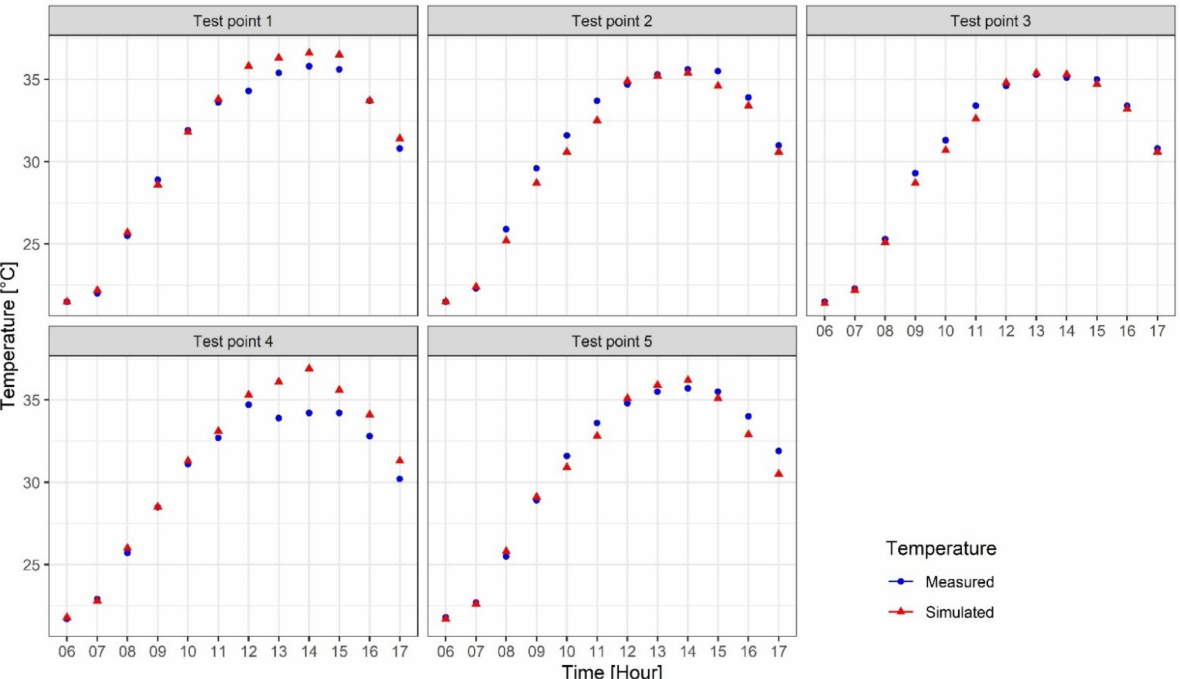
Figure 5. Temporal behavior of temperature data simulated and measured at each test